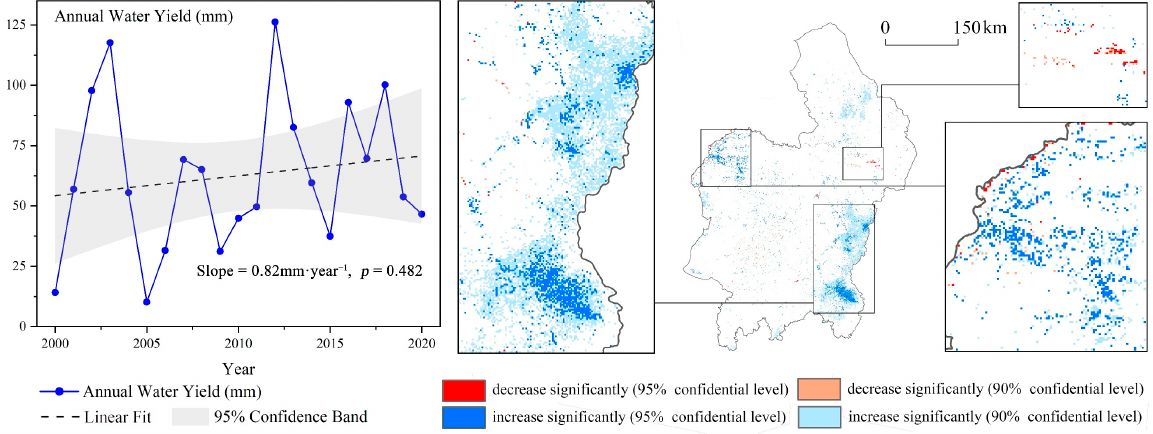
Figure 4. Spatial-temporal variation trends of water yield.